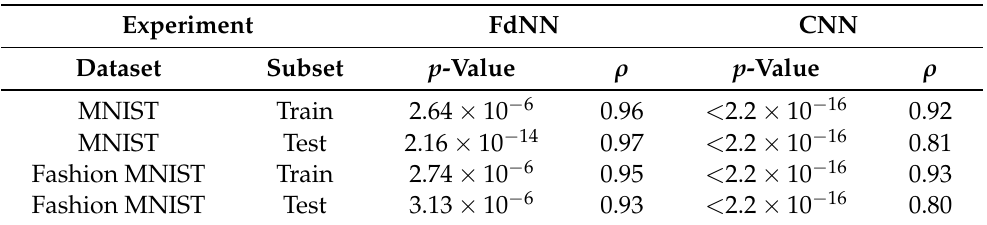
Table 1. Spearman’s correlation test between the number of synapses and the categorical accuracy for each simulation experiment.